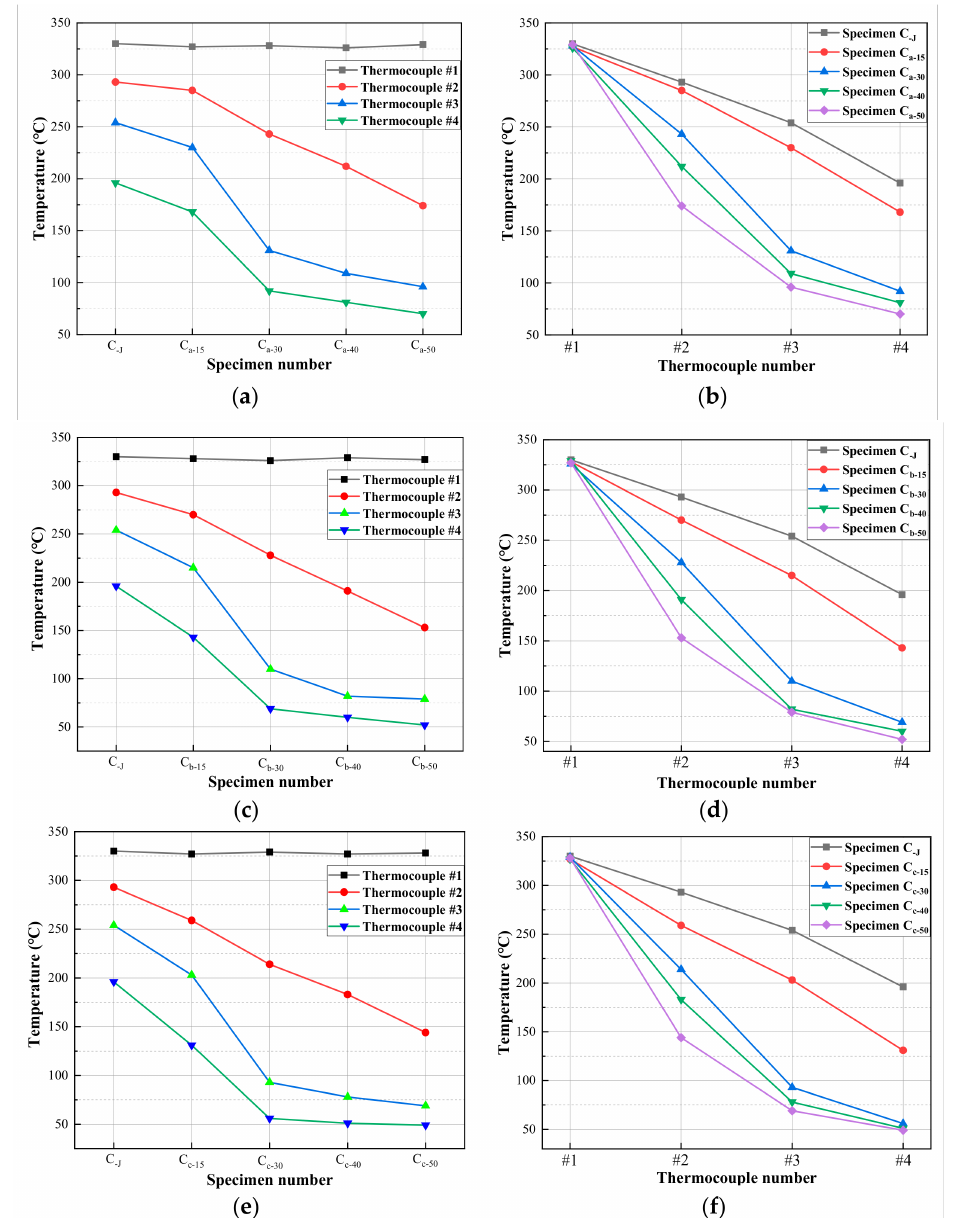
Figure 11. Temperature variation of the thermocouples in each specimen: ( a ) Specimen no-temperature curve (rubber particle size 3~5 mm), ( b ) thermocouple no-temperature curve (rubber particle size 3~5 mm), ( c ) specimen no-temperature curve (rubber particle size 1~3 mm), ( d ) thermocouple no-temperature curve (rubber particle size 1~3 mm), ( e ) specimen no-temperature curve (rubber particle size 40 mesh), and ( f ) thermocouple no-temperature curve (rubber particle size 40